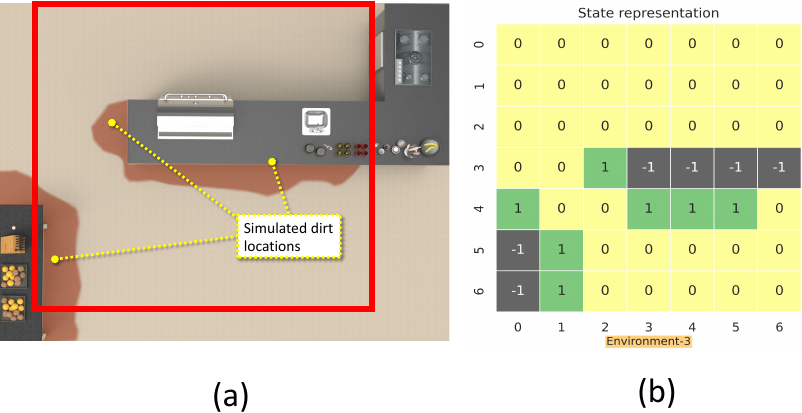
Figure 6. The simulation environment 3 ( a ), and 7 × 7 reduced environment representation ( b ).